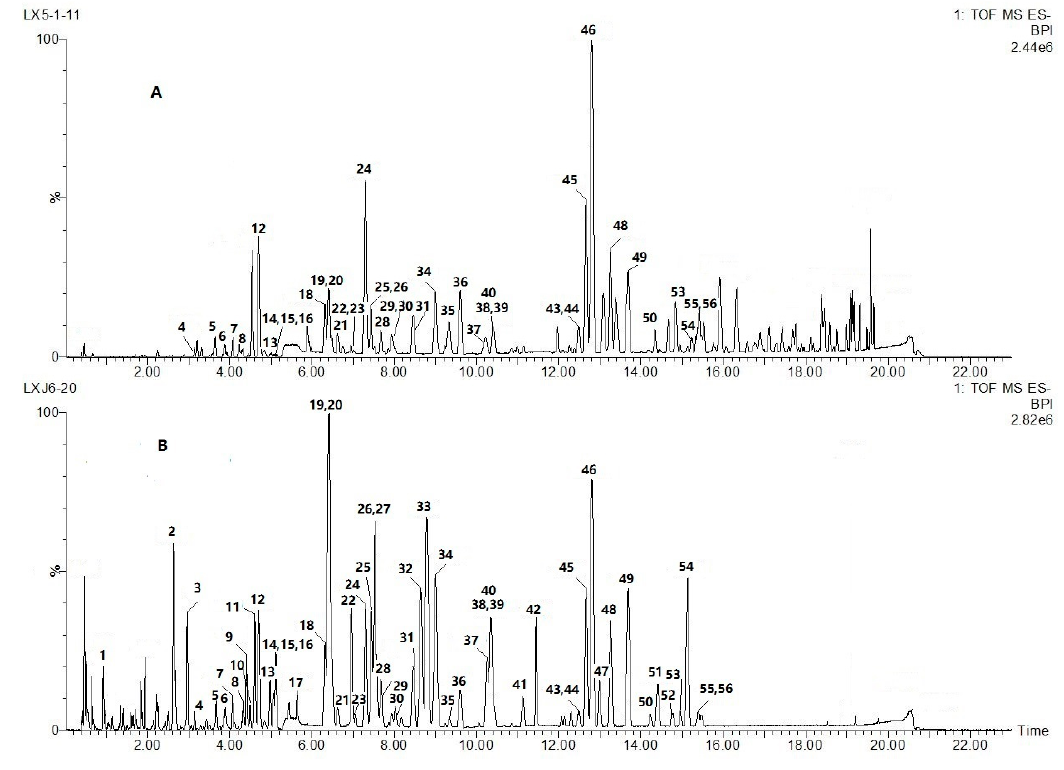
Figure 1. Representative basic peak ion (BPI) chromatograms of natural and artificial Resina Draconis in negative ion mode by ultra-high-performance-liquid-chromatography with quadrupole time of flight mass spectrometry (UHPLC-QTOF-MS/MS). ( A ) Natural Resina Draconis sample ( NRD ); ( B ) artificial induced Resina Draconis ( AIRD ) sample. The peak numbers are the same as displayed in